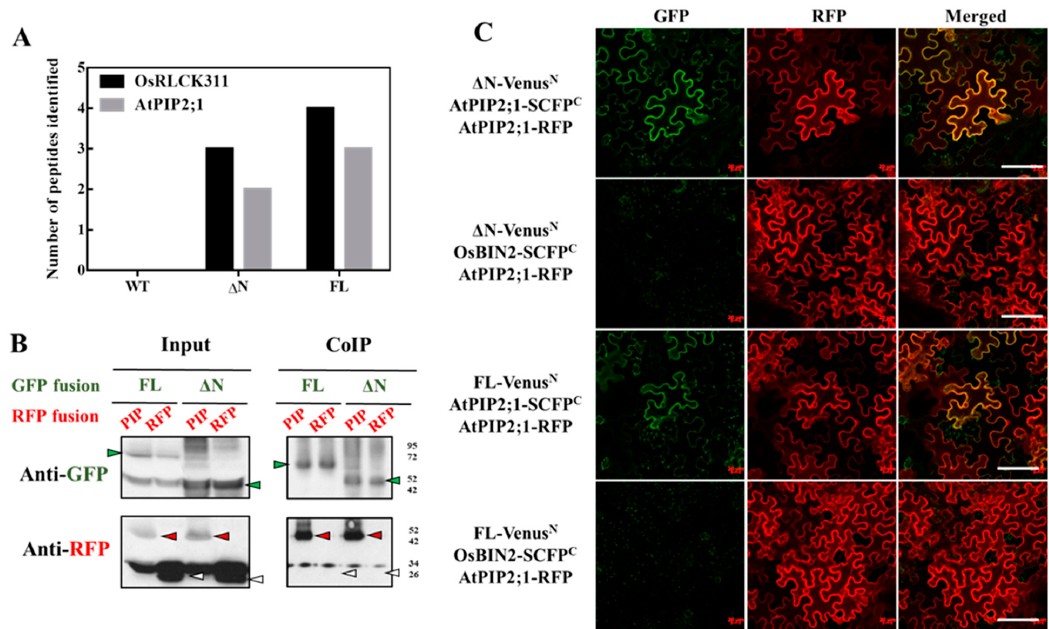
Figure 2. Rice RLCK (OsRLCK311) interacts with an aquaporin protein AtPIP2;1 in vivo. ( A ) AtPIP2;1 interacts with both ∆ N and full-length (FL) through co-immunoprecipitation and identified by MS. ( B ) Co-immunoprecipitation of ∆ N or FL with AtPIP2;1 by transient expression in Nicotiana benthamiana , identified by western blots. The proteins extracted from tobacco leaves infiltrated with both ∆ N-GFP / FL-GFP (green arrows) and AtPIP2;1-RFP (red arrows) were co-immunoprecipitated (IP) with anti-GFP antibodies and blotted with anti-GFP or anti-red fluorescent protein (RFP) antibodies. Free RFP is marked in white arrows. ‘’Input’’ stands for protein extracts before immunoprepicitaton. ( C ) Bimolecular fluorescence complementation (BiFC) analysis of the interaction between ∆ N or FL with AtPIP2;1 by transient expression in Nicotiana benthamiana . Venus N was fused at the C-terminus of Δ N and FL, while SCFP C was fused to the C-terminus of AtPIP2;1 and OsBIN2. Infiltration with OsBIN2-SCFP C were used as negative controls. AtPIP2;1-mcherry was used as a plasma membrane marker. Bar = 200 µM.